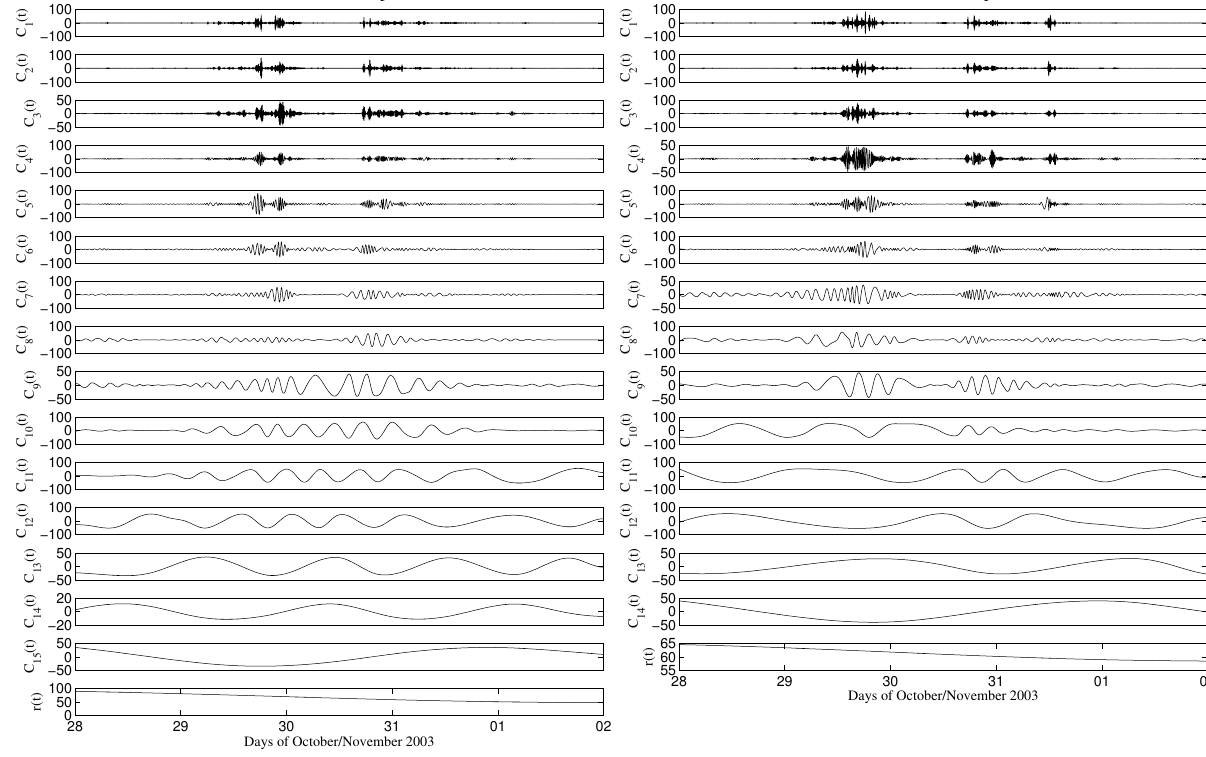
Figure 14. Halloween super storm, 28 October–1 November 2003: empirical modes extracted via EMD from GOES10 (left panels) and GOES12 (right panels) B z components. The modes and the residues are expressed in nanotesla, and the time resolution is